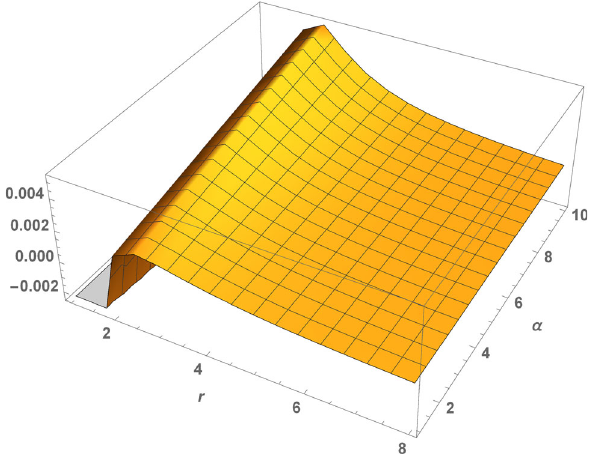
Fig. 8 Violation of dominant energy condition (DEC), ρ ≥ | p r | , for λ = − 35 and different α